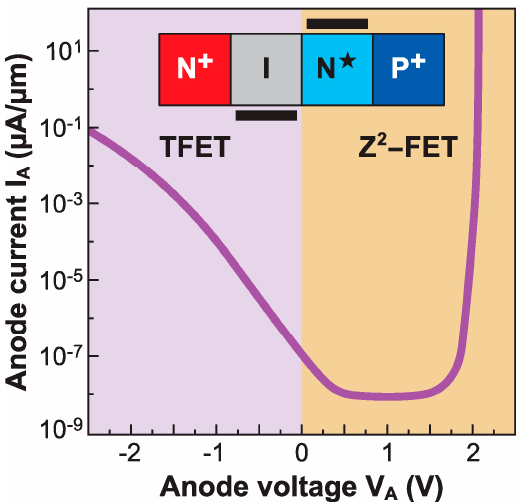
Figure 24. Experimental current vs. anode voltage characteristics showing the same device operating as a TFET (for V A < 0) and a Z 2 –FET (for V A > 0, adapted from [12]).